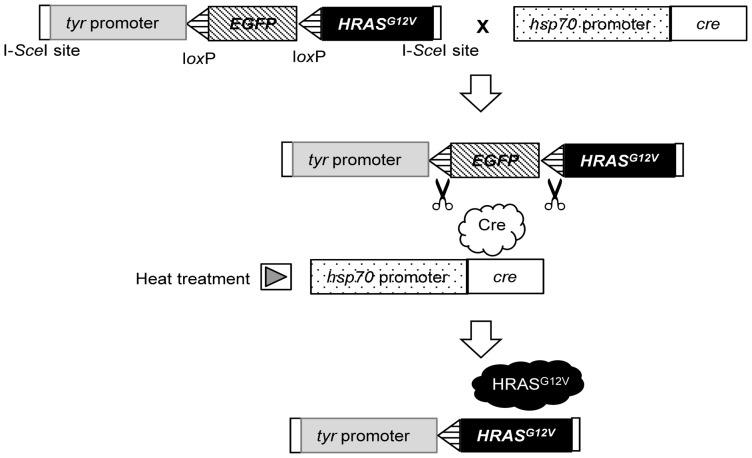
Generation of transgenic medaka expressing human HRASG12V.A plasmid containing the human HRASG12V cDNA downstream of the medaka tyrosinase gene (tyr) promoter as well as the EGFP gene positioned between loxP sequences was constructed for the generation of transgenic medaka. These transgenic fish were crossed with another transgenic line harboring the gene for Cre recombinase (cre) under the control of the medaka hsp70 promoter. The resulting double-transgenic animals express Cre recombinase after exposure to heat shock, resulting in excision of the EGFP gene and expression of HRASG12V.